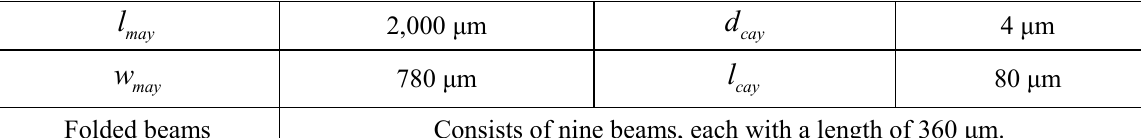
Table 4. Dimensions of X/Y-axis accelerometer.